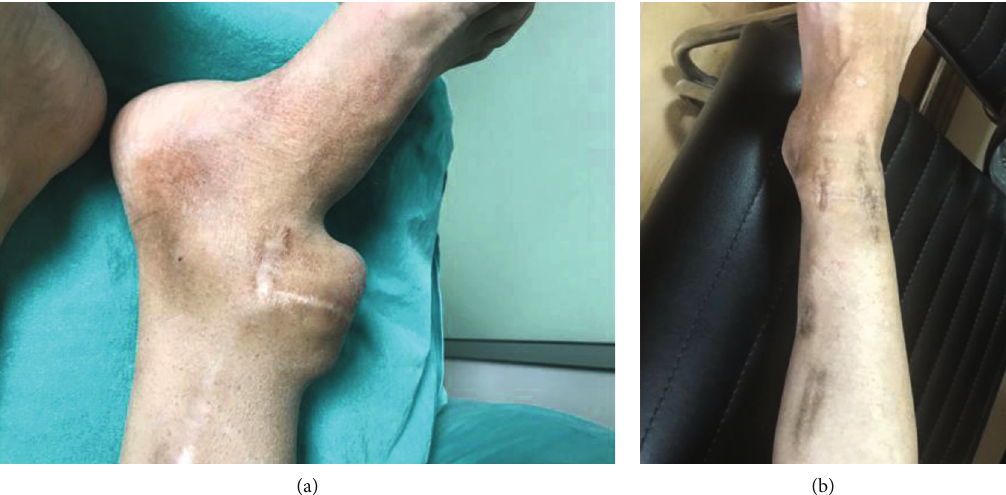
Figure 1: (a) Aneurysm and surgical incisions on right ankle (transverse scar is due to aneurysmoplasty operation performed nine years ago). (b) Image of the right ankle at the 3rd year